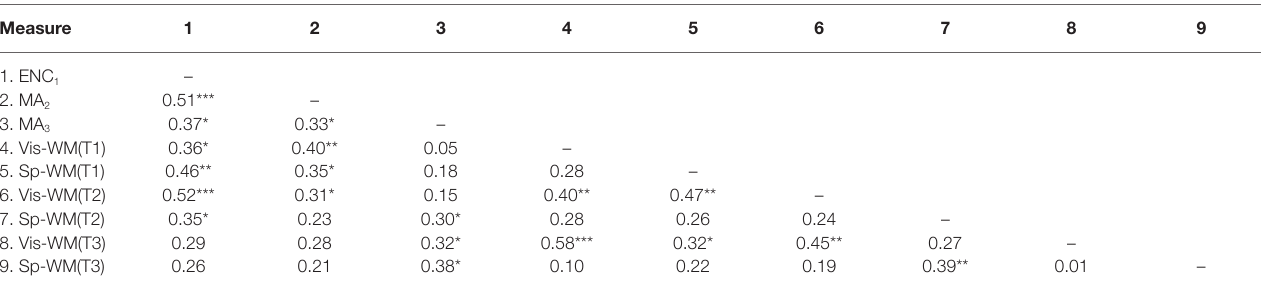
TABLE 2 | Pearson’s r correlation between active VSWM measures and early numerical competence tasks at T1 and numerical intelligence at T2 and T3 ( n = 43).